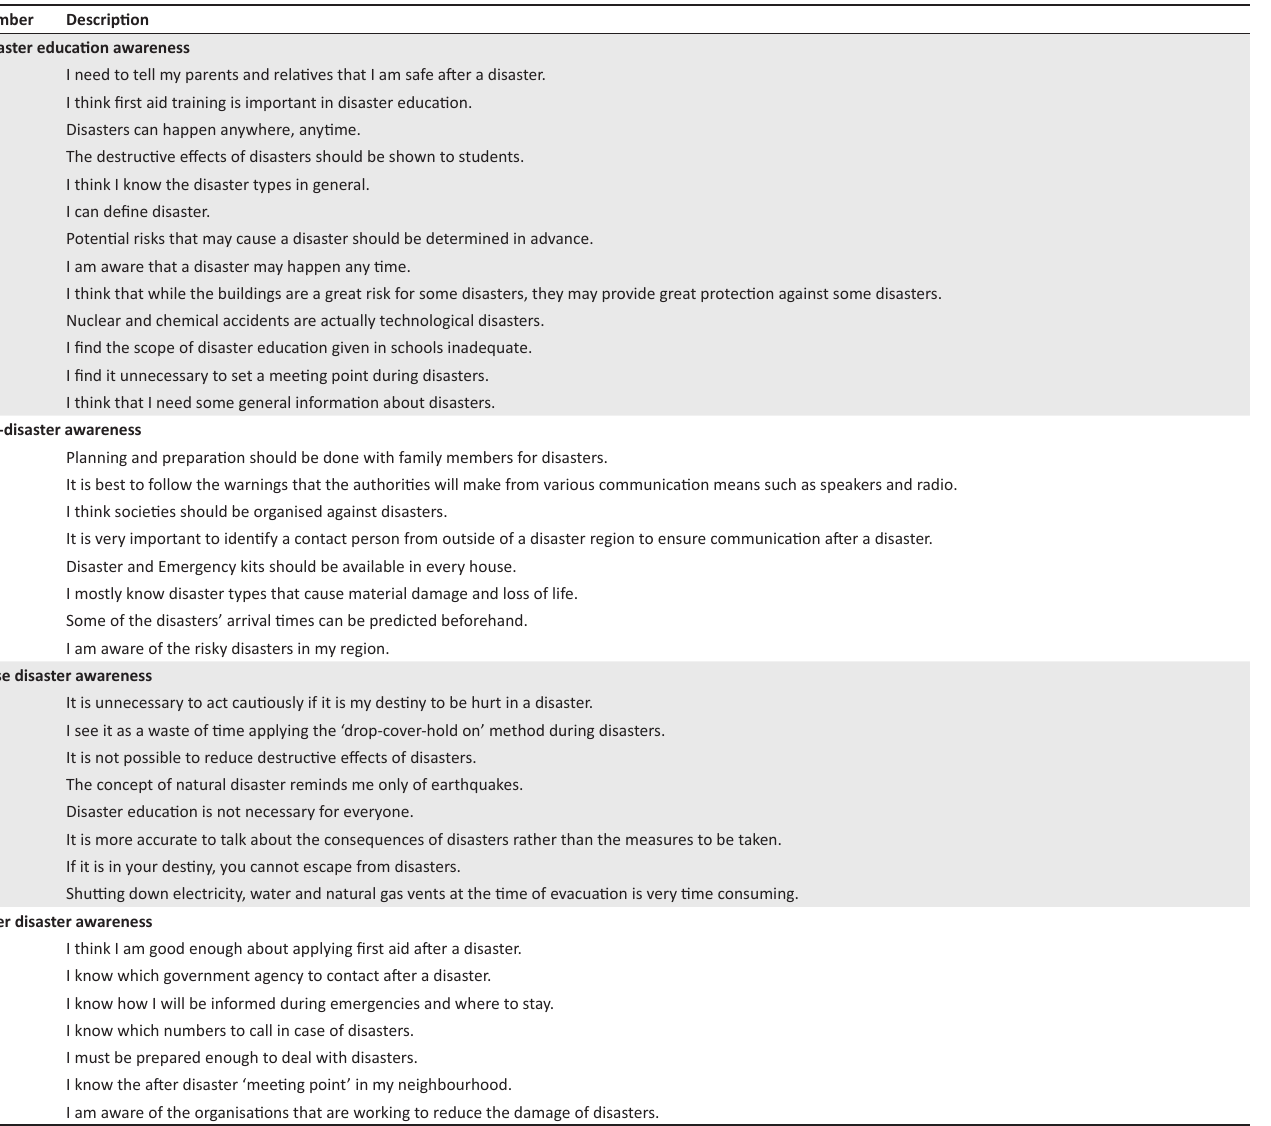
TABLE 1-A1: Disaster Awareness